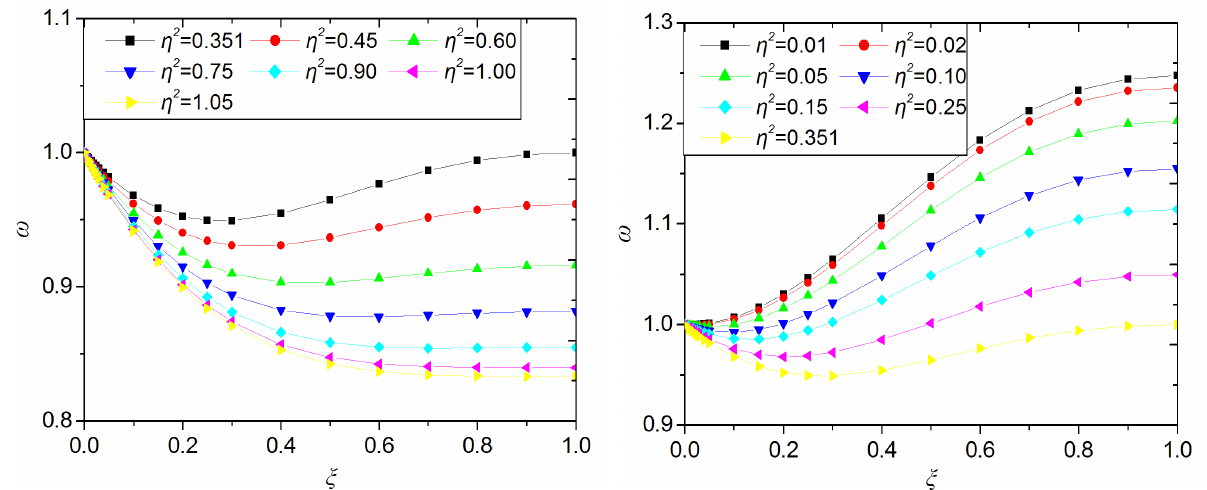
Figure 3. Energy variation with η 2 and ξ .